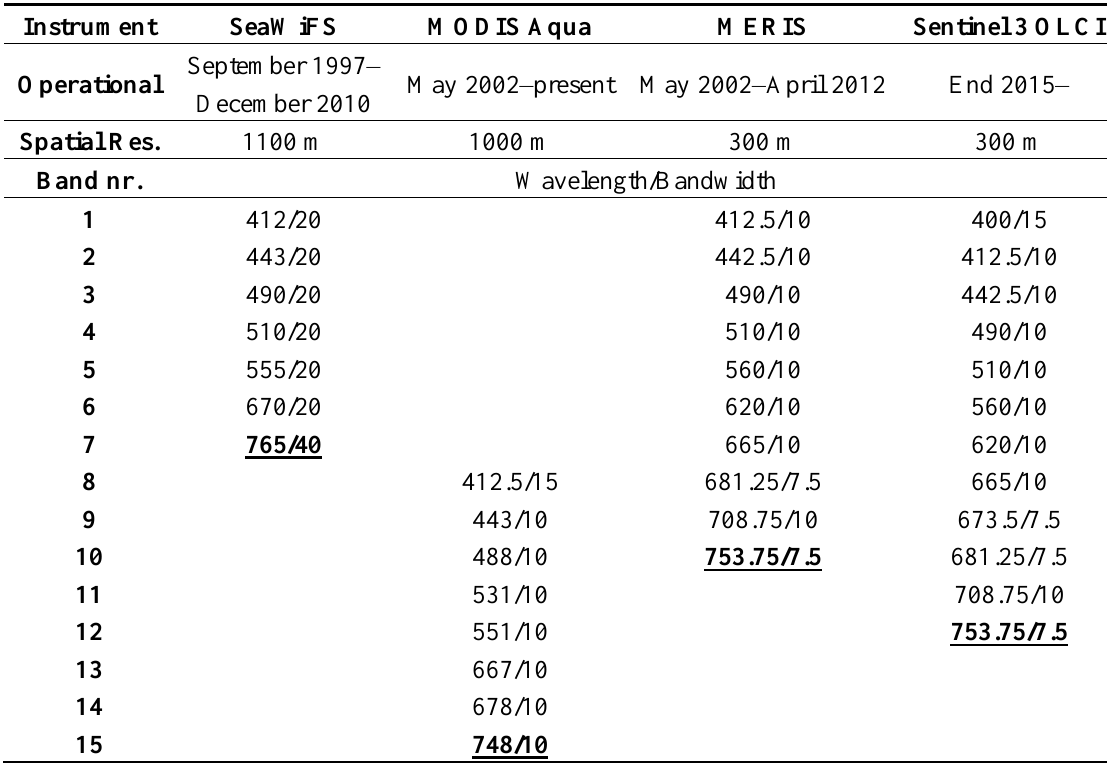
Table 1. Band settings of ocean colour instruments. The central wavelength and band width are given in nm. Bands in bold with underscore are outside visual domain. Instrument SeaWiFS MODIS Aqua MERIS Operational Spatial Res. 1100 m 1000 m 300 m 300 m Band